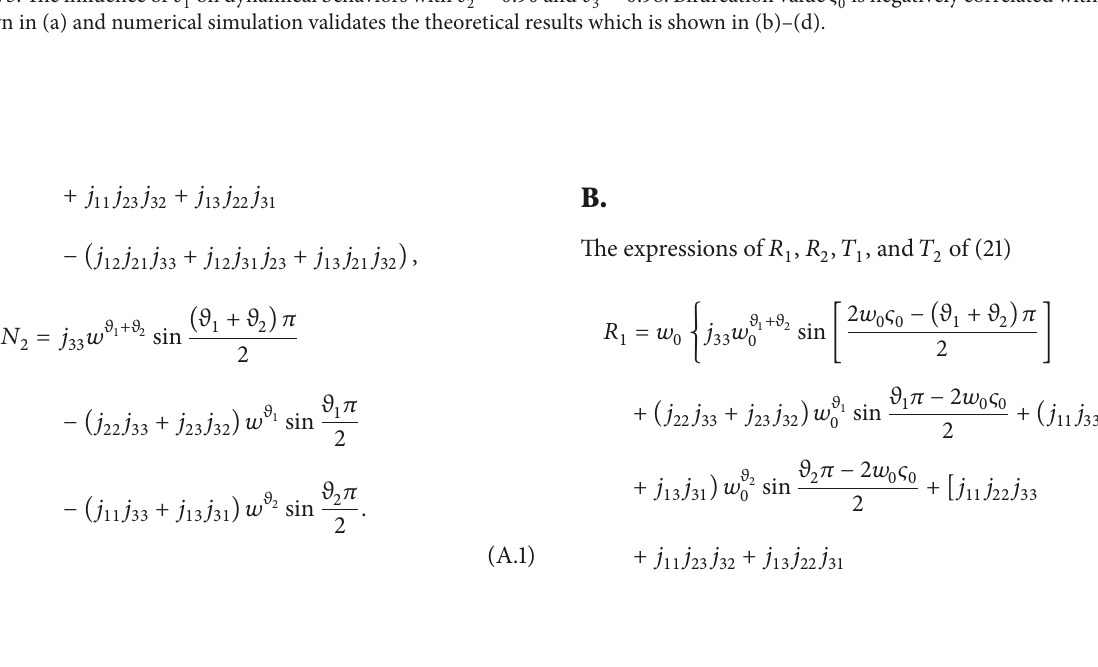
Figure 5: The influence of 𝜗 1 on dynamical behaviors with 𝜗 2 = 0.90 and 𝜗 3 = 0.98 . Bifurcation value 𝜍 0 is negatively correlated with 𝜗 1 which is shown in (a) and numerical simulation validates the theoretical results which is shown in